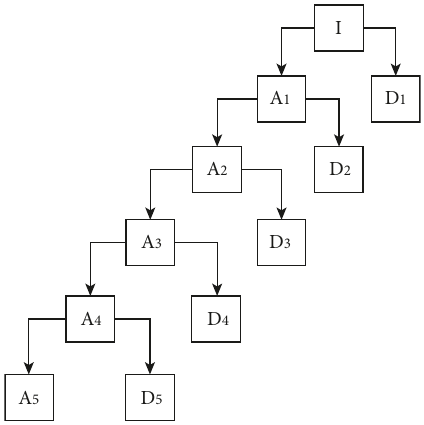
Figure 5: Flow chart of wavelet